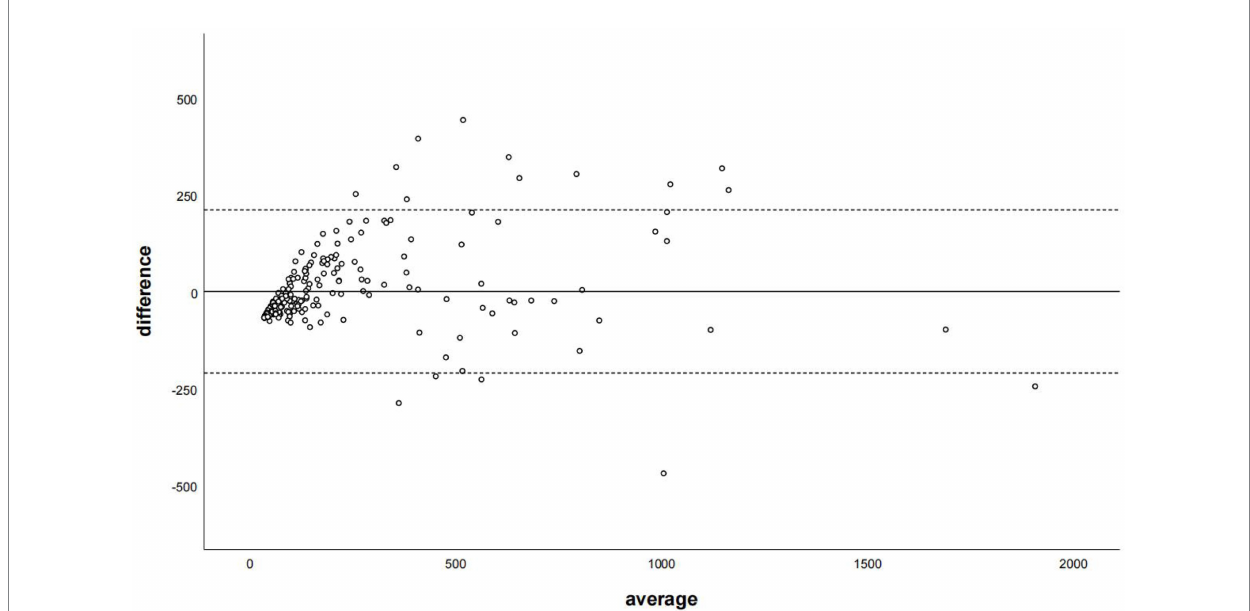
FIGURE 4 The Bland–Altman plot was used to describe the agreement of coronary artery calcium score between the non-contrast images and virtual non- contrast images corrected by the regression equation of the overall calcium score. The average represented the mean value of calcium score from two images, and the difference represented the different value of calcium score from two